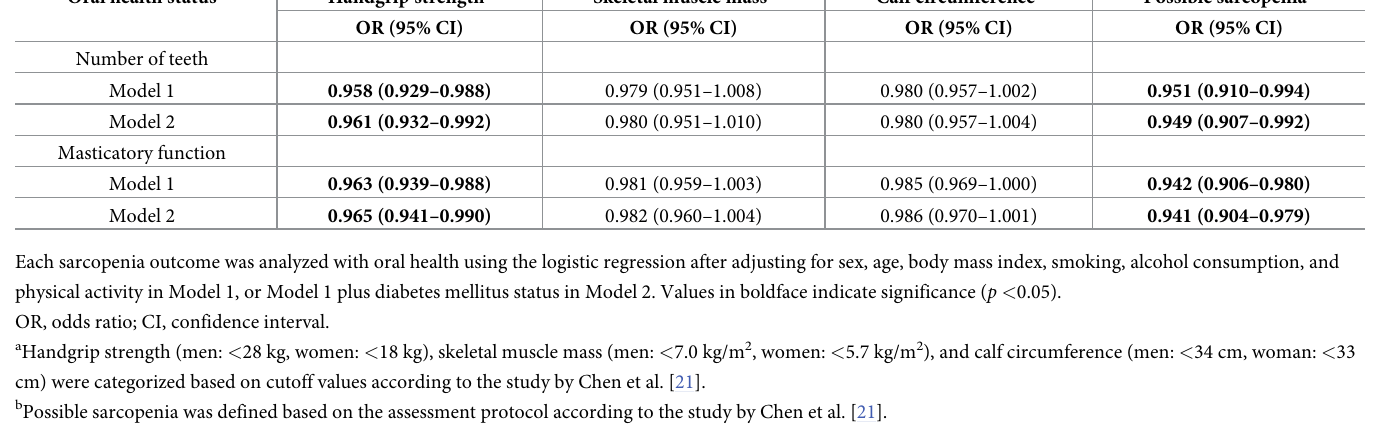
Table 2. Association between oral health status and sarcopenia status among community-dwelling Japanese adults (N = 635).